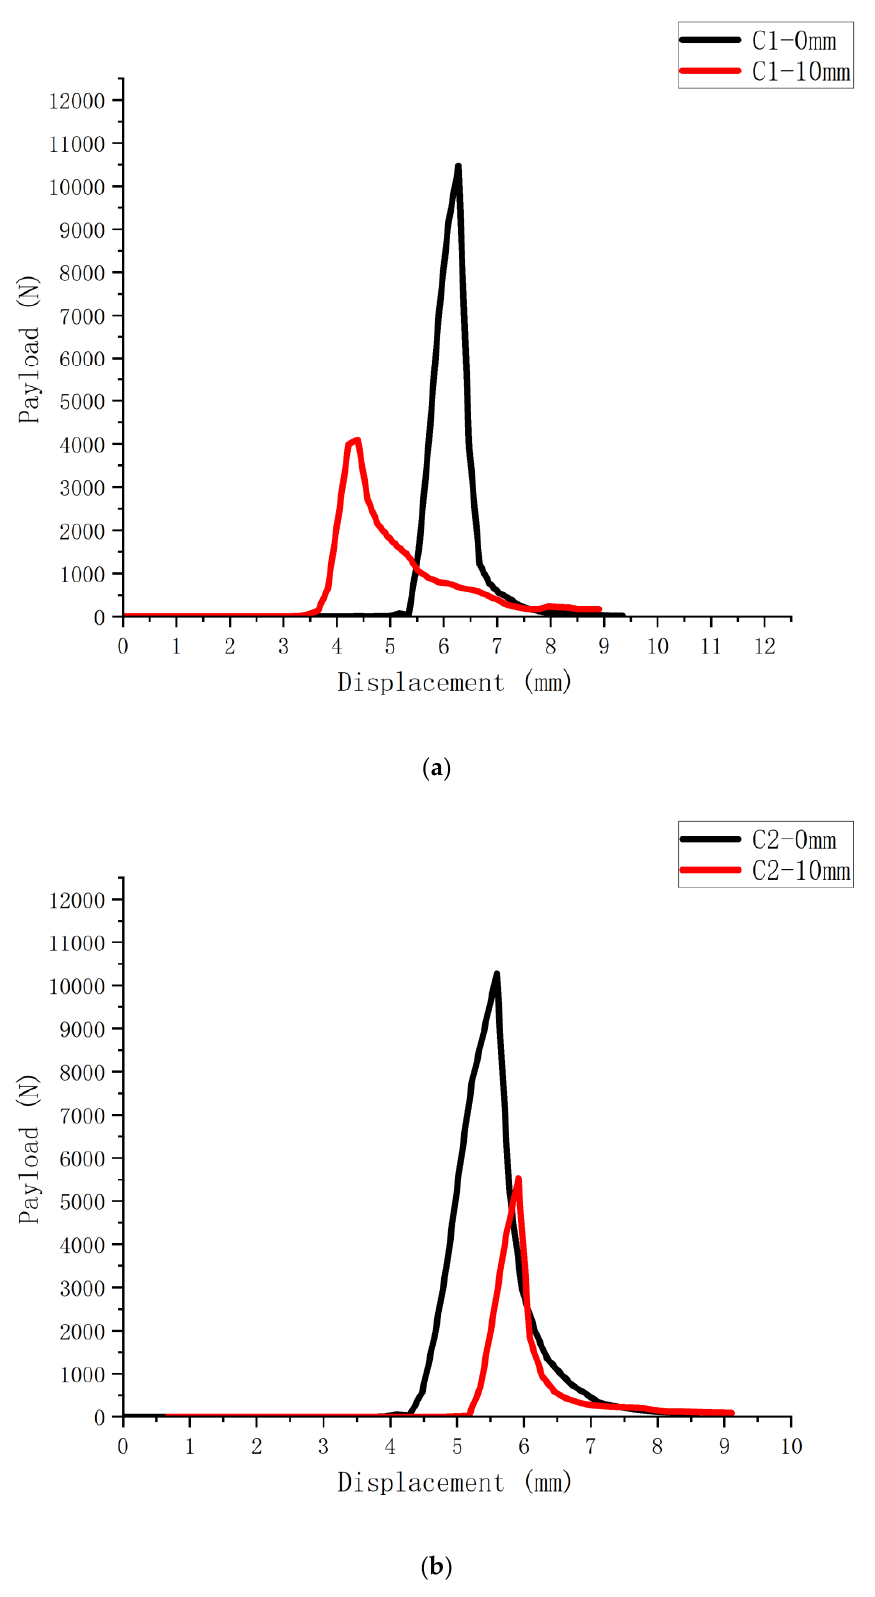
Figure 4. Load-displacement curves of long-term aged asphalt mixture SCB specimens:. ( a ) C1 asphalt mixture SCB test curve; ( b ) C2 asphalt mixture SCB test curve.